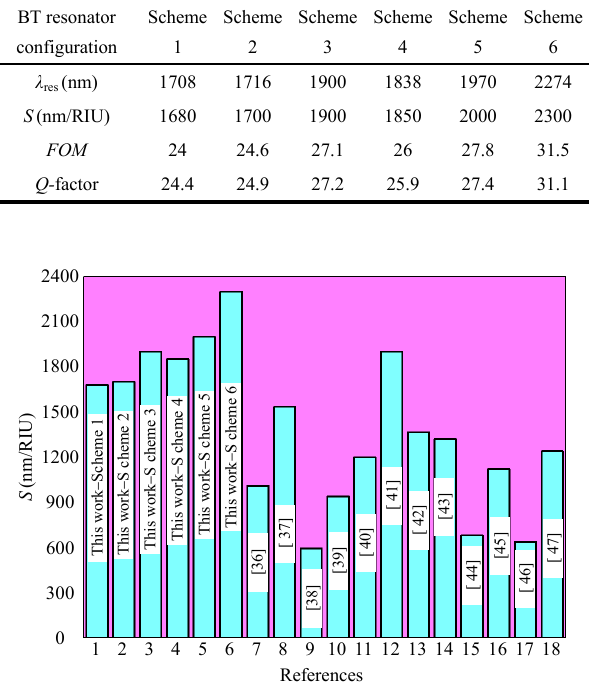
Fig. 6 Sensitivity comparison between the proposed BT configurations and previously proposed